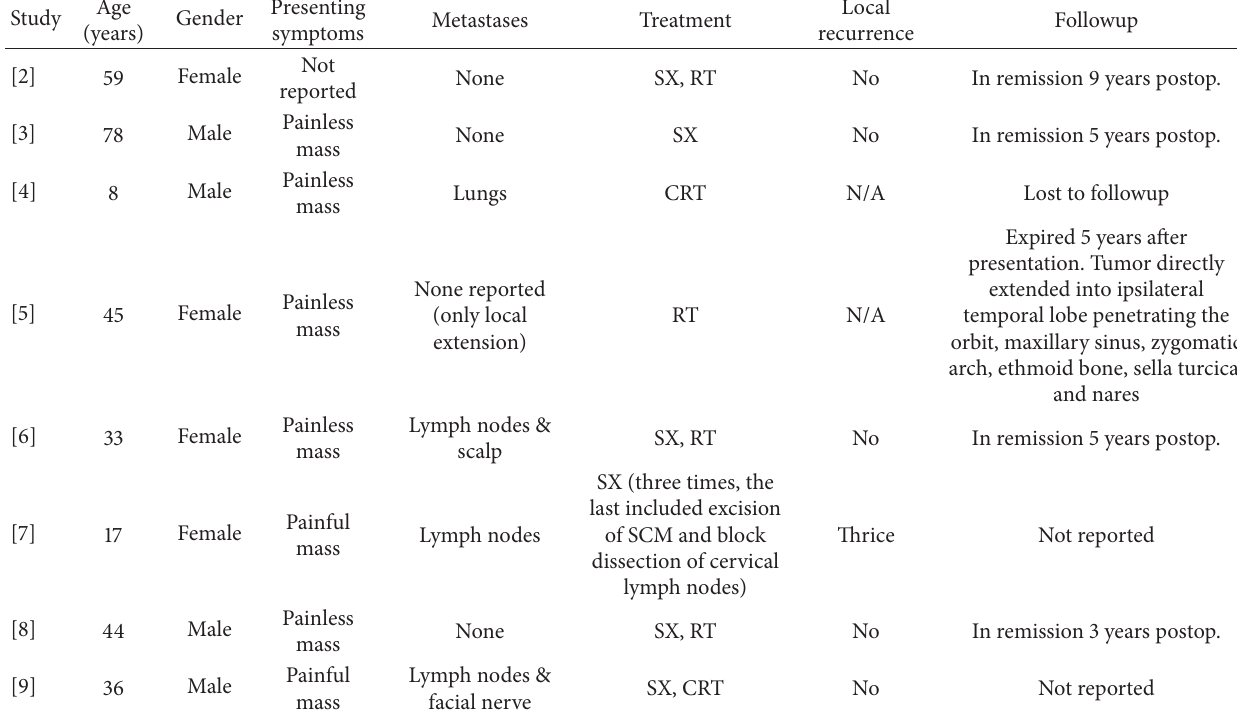
Table 1: Literature review of eight primary parotid